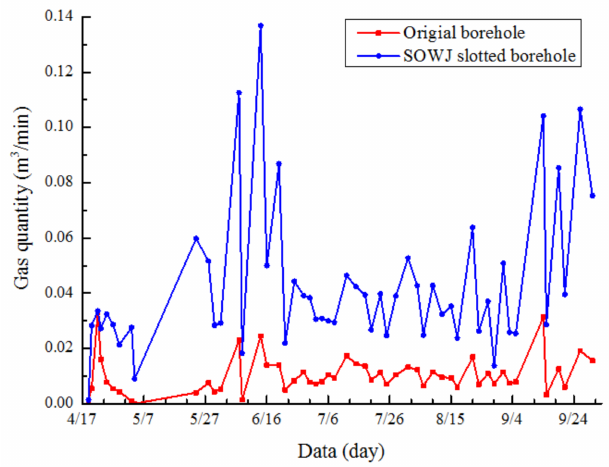
Figure 21. Gas quantity of standard and SOWJ slotting